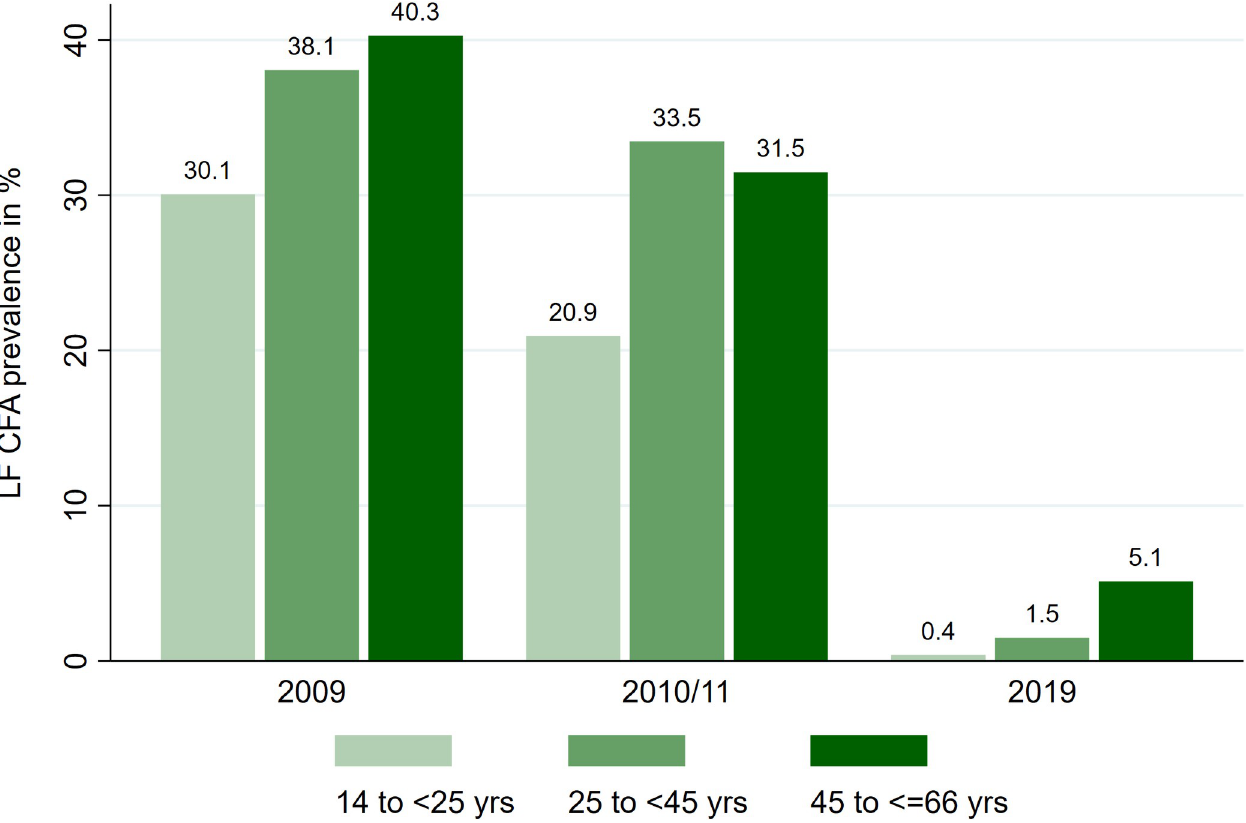
Fig 2. LF prevalence categorized by age group. The LF prevalence (defined by the level of circulating filarial antigens) is increasing with older age in the two EMINI surveys (2009 and 2010/11) as well as in the RHINO study (2019).